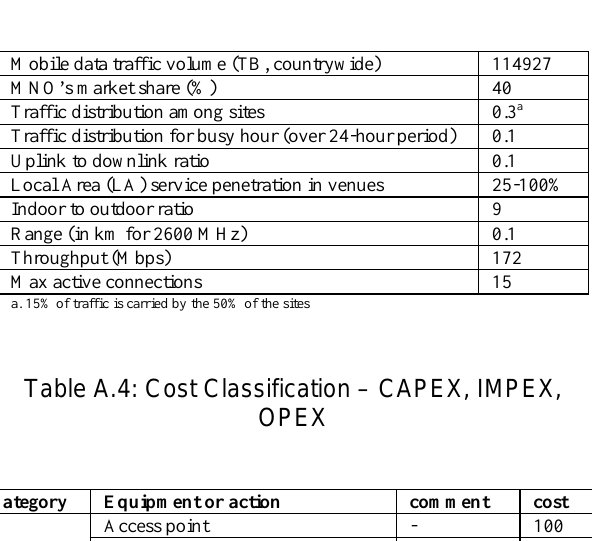
Table A.3: Market, traffic characteristic and access point design parameters (2H/2013)